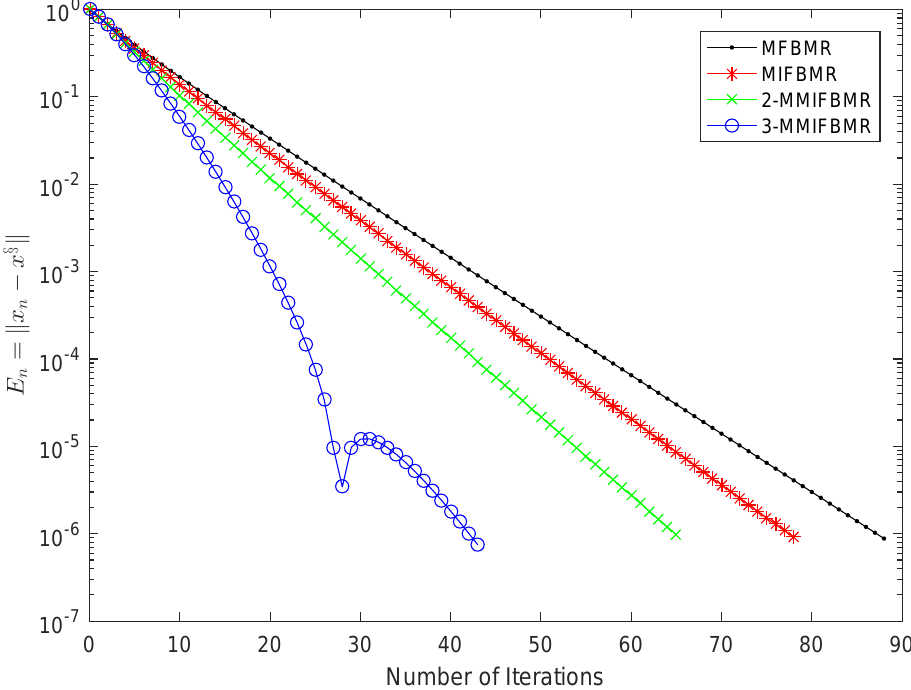
Figure 1. Comparison of MFBMR, MIFBMR, 2-MMIFBMR and 3-MMIFBMR in Example